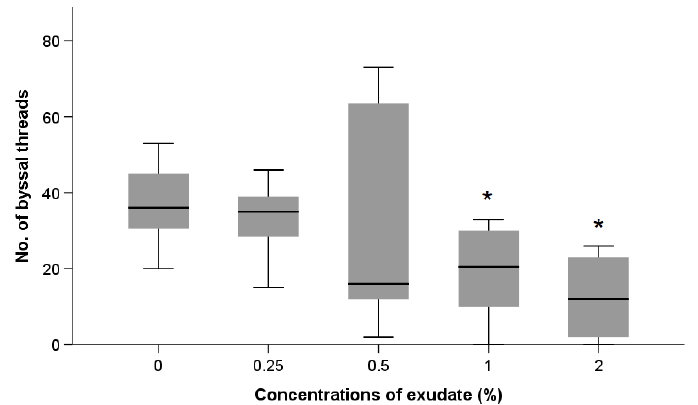
Figure 7. Number of byssal threads produced by M. galloprovincialis during 96 h of exposure to different concentrations of A. armata exudate. * denotes a statistically significant difference compared to control (0%).